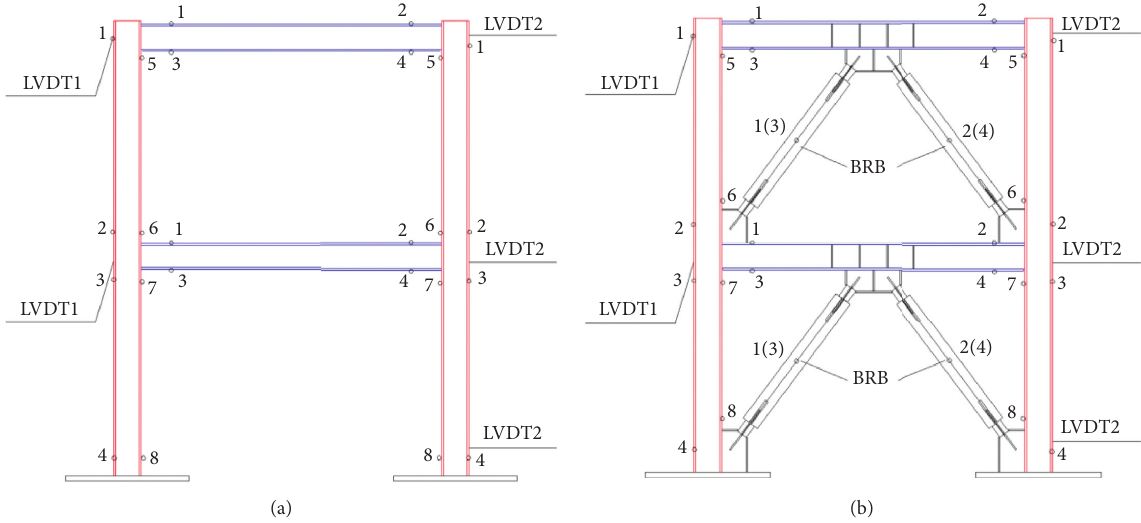
Figure 10: Layout of measuring points. (a) Pure frame. (b) BRB frame.